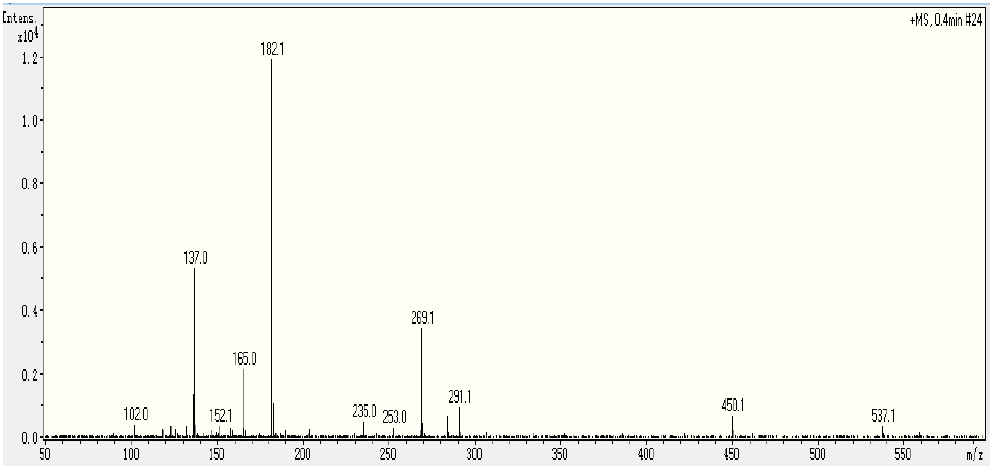
Figure 4. ESI-MS/MS chromatography of P3D5.